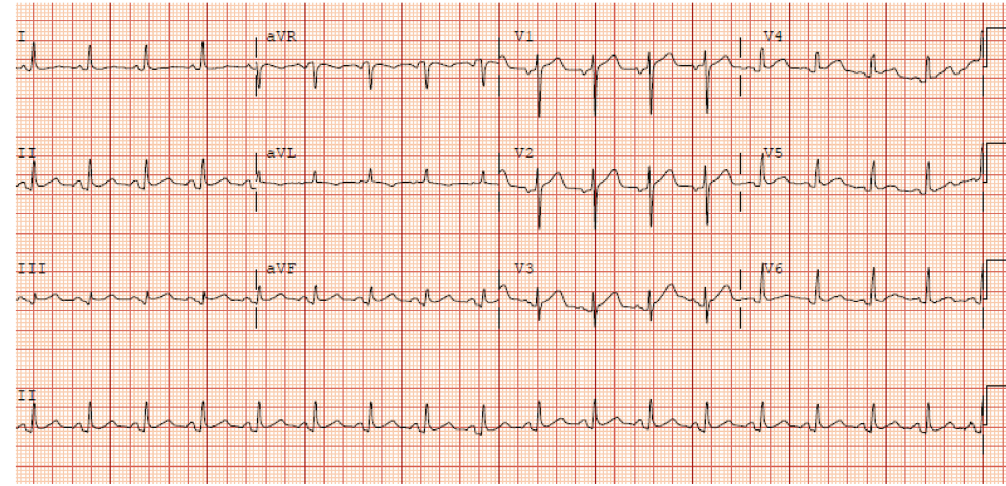
Figure 1: 12-lead electrocardiogram obtained on arrival of the patient to the emergency department 3 days after undergoing TURBT with intravesical mitomycin C instillation showing diffuse concave STelevations with PR depressions in all leads, except in aVR which showed ST depression and PR